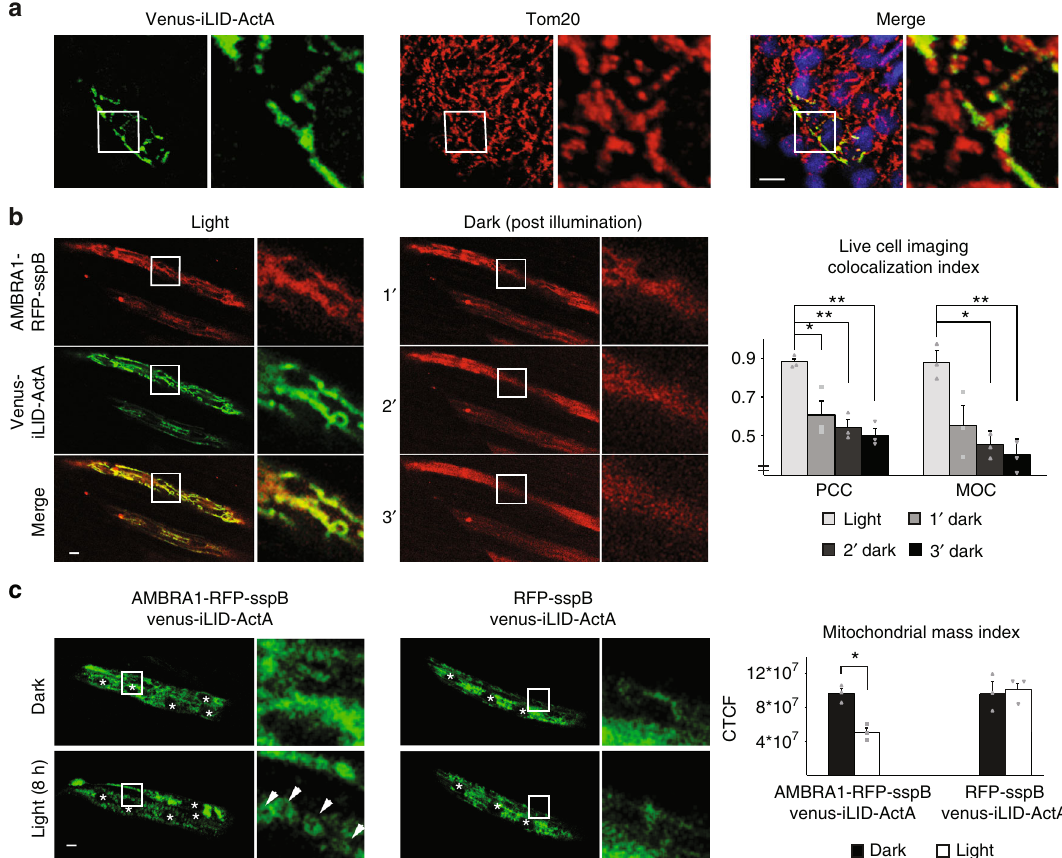
Fig. 5 In vivo induction of mitophagy through an optogenetic bimodular system. a Zebra fi sh embryos were microinjected with a Venus-iLID-ActA overexpressing plasmid, then fi xed 48-hpf and whole mount immuno-stained for Tom20 (red). Nuclei were counterstained with DAPI (blue). Inset: ×4 magni fi cation. Scale bar: 10 μ m. b Venus-iLID-ActA/AMBRA1-RFP-sspB microinjected zebra fi sh embryos were illuminated with blue light and then kept in the dark for 3 min, mimicking the experiment shown in Fig. 3a. Double-positive muscle fi bers were photographed in order to analyze Venus-iLID-ActA/ AMBRA1-RFP-sspB dynamic interactions. PCC and MOC of the red over the green signal were quanti fi ed in three independent experiments. Inset: ×6 magni fi cation. Scale bar: 10 μ m. Data shown: mean ± S.E.M. Hypothesis test: ANOVA test. * p < 5 × 10 − 2 . ** p < 10 − 2 . c Venus-iLID-ActA/AMBRA1-RFP-sspB or Venus-iLID-ActA/RFP-sspB (negative control) double positive zebra fi sh embryos were illuminated for 8 h with a pulsed (2 s light/2 min dark) blue light; muscle fi bers were analyzed. Upon light stimulation, round-shaped mitochondria (arrowheads) were clearly visible in AMBRA1-RFP-sspB but not RFP-sspB positive fi bers. Images are the sum of three frames Z-stack. Stars indicate nuclei. Graphs show the overall reduction per single fi ber of the Venus-iLID-ActA signal intensity corrected for the background in three independent experiments. Inset: ×8 magni fi cation. Scale bar: 10 μ m. Data shown: mean ± S.E.M. Hypothesis test: ANOVA test. * p < 5 × 10 − 2 . Source data are provided as a Source Data fi